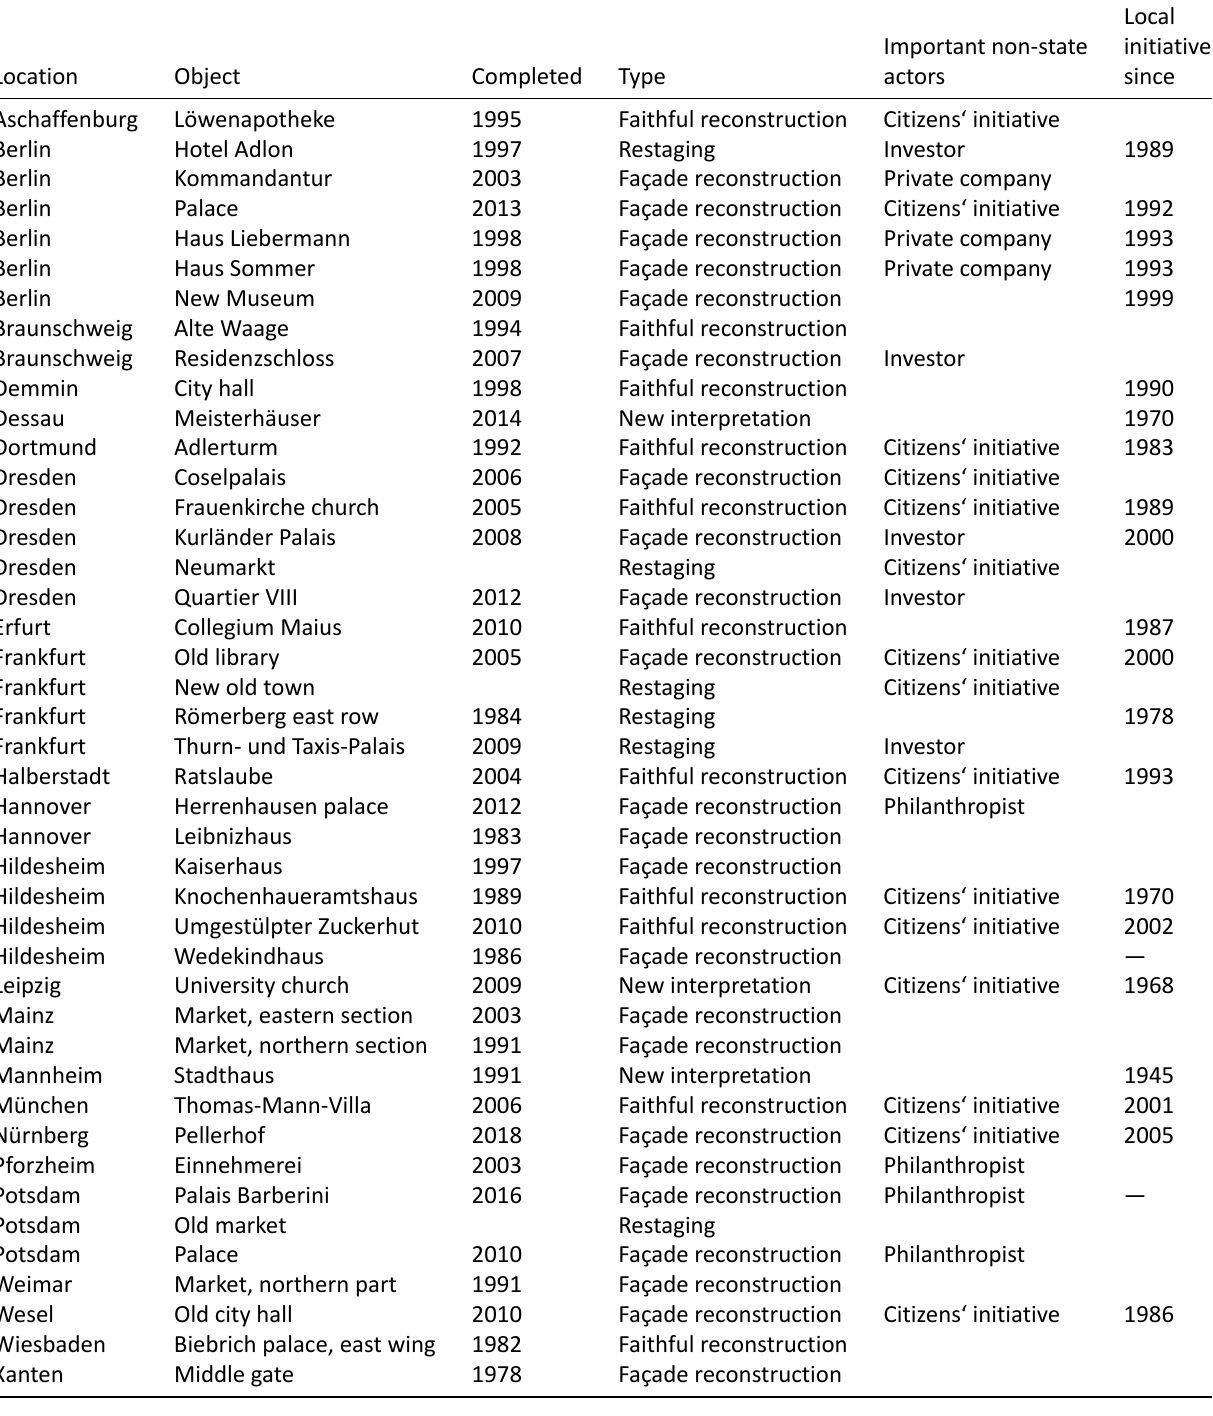
Table 1. Overview of completed reconstructions in the recent